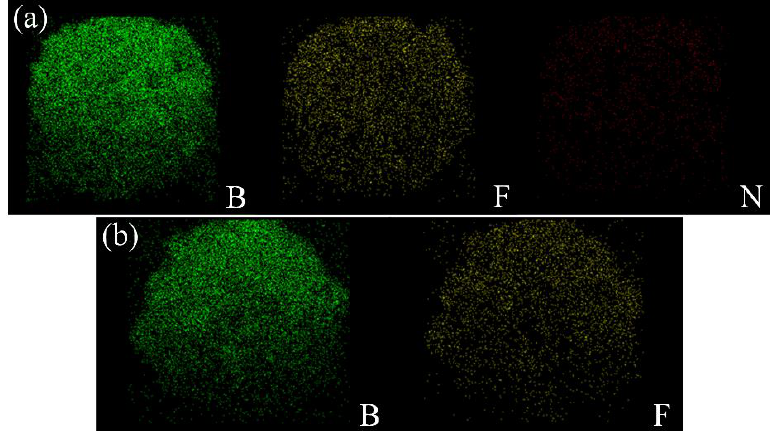
Figure 4. EDS elemental mapping of ( a ) nB@F2603@CL-20 and ( b ) nB@F2603 microspheres.